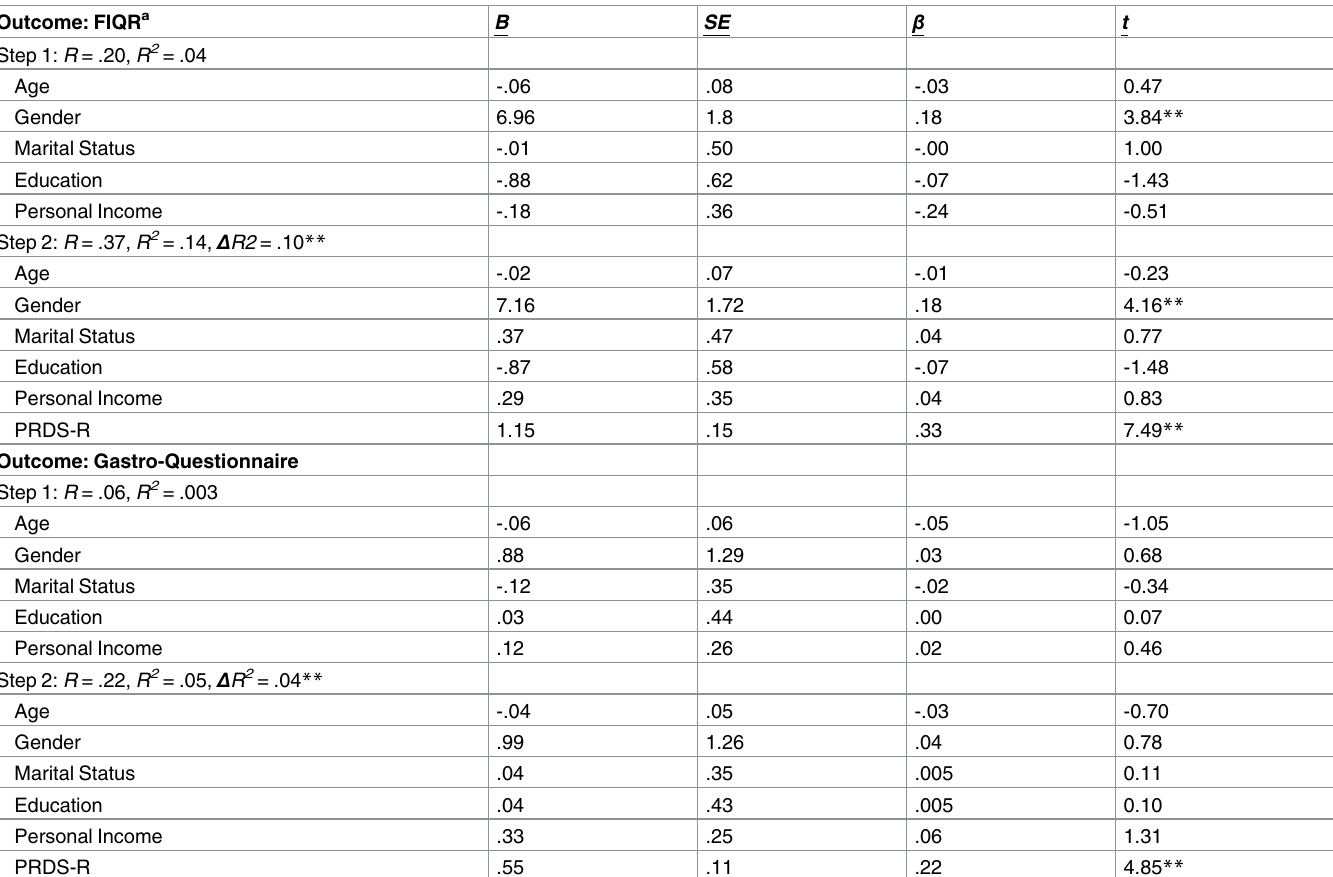
Table 3. Results of four regression analyses of PRDS-R scores as predicting scores on outcome measuresbeyond variancecontributed by key demographic variables. Outcome: FIQR a B SE β